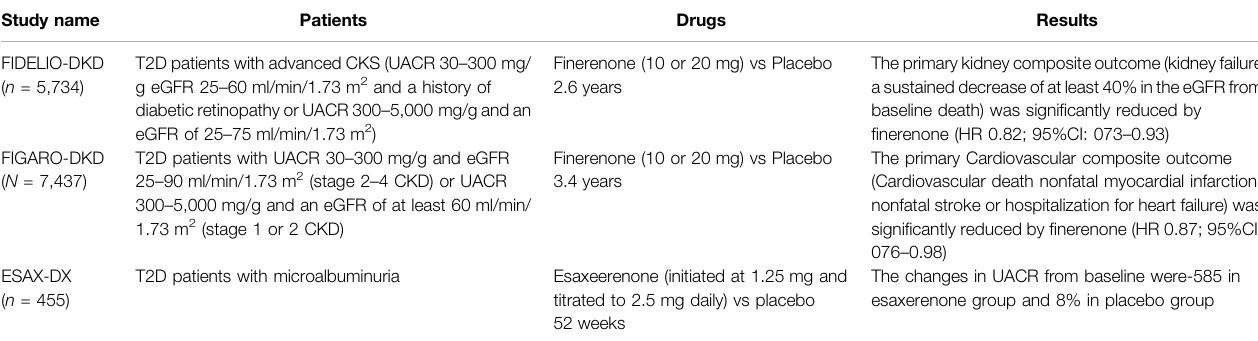
TABLE 2 | Key clinical trials of nonsteroidal MRAs. The renoprotective effects fi nerenone and esaxerenone have been reported thus far. The primary endpoint of FIDELIO- DKD was kidney composite outcome (Bakris et al., 2020). In FIGARO-DKD, the primary endpoint was cardiovascular composite outcome. FIGARO-DKD included relatively earlier stage of DKD patients compared to FIDELIO-DKD (Pitt et al., 2021). Patients Drugs FIDELIO-DKD ( n (cid:1)